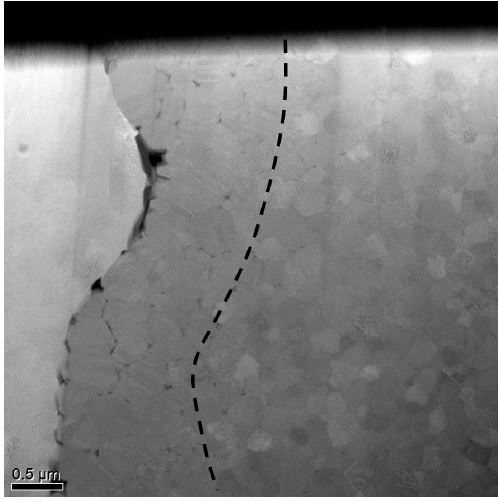
Figure 6. YSZ grains in the ceramic layer and near the interface.